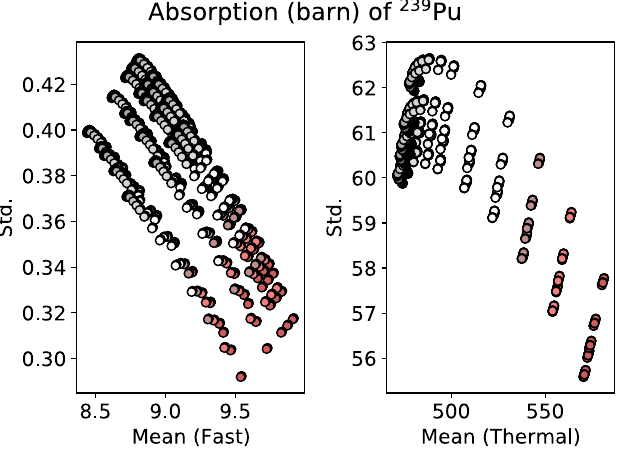
Fig. 1. Mean and standard deviation (Std) of the pin-wise neutron production cross section of 235 U in the UGd fuel assembly.